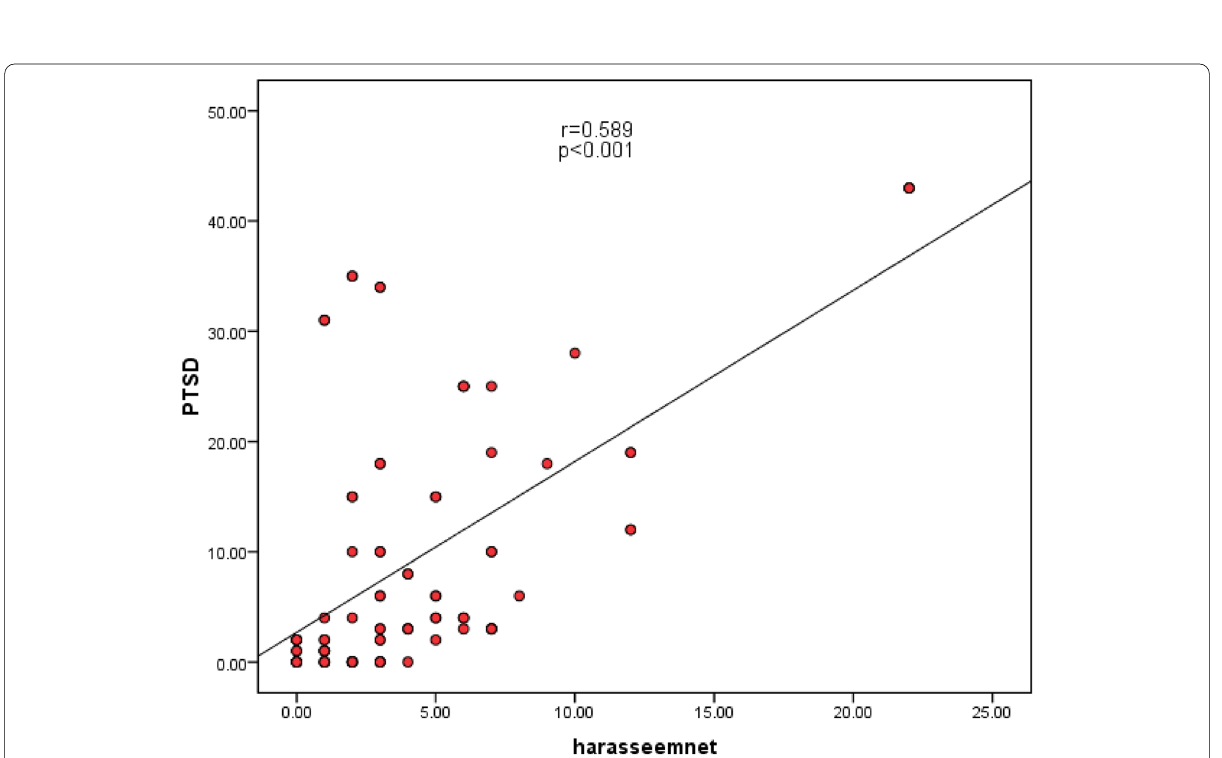
Fig. 4 Scatter diagram showing a correlation between harassment and post-traumatic stress